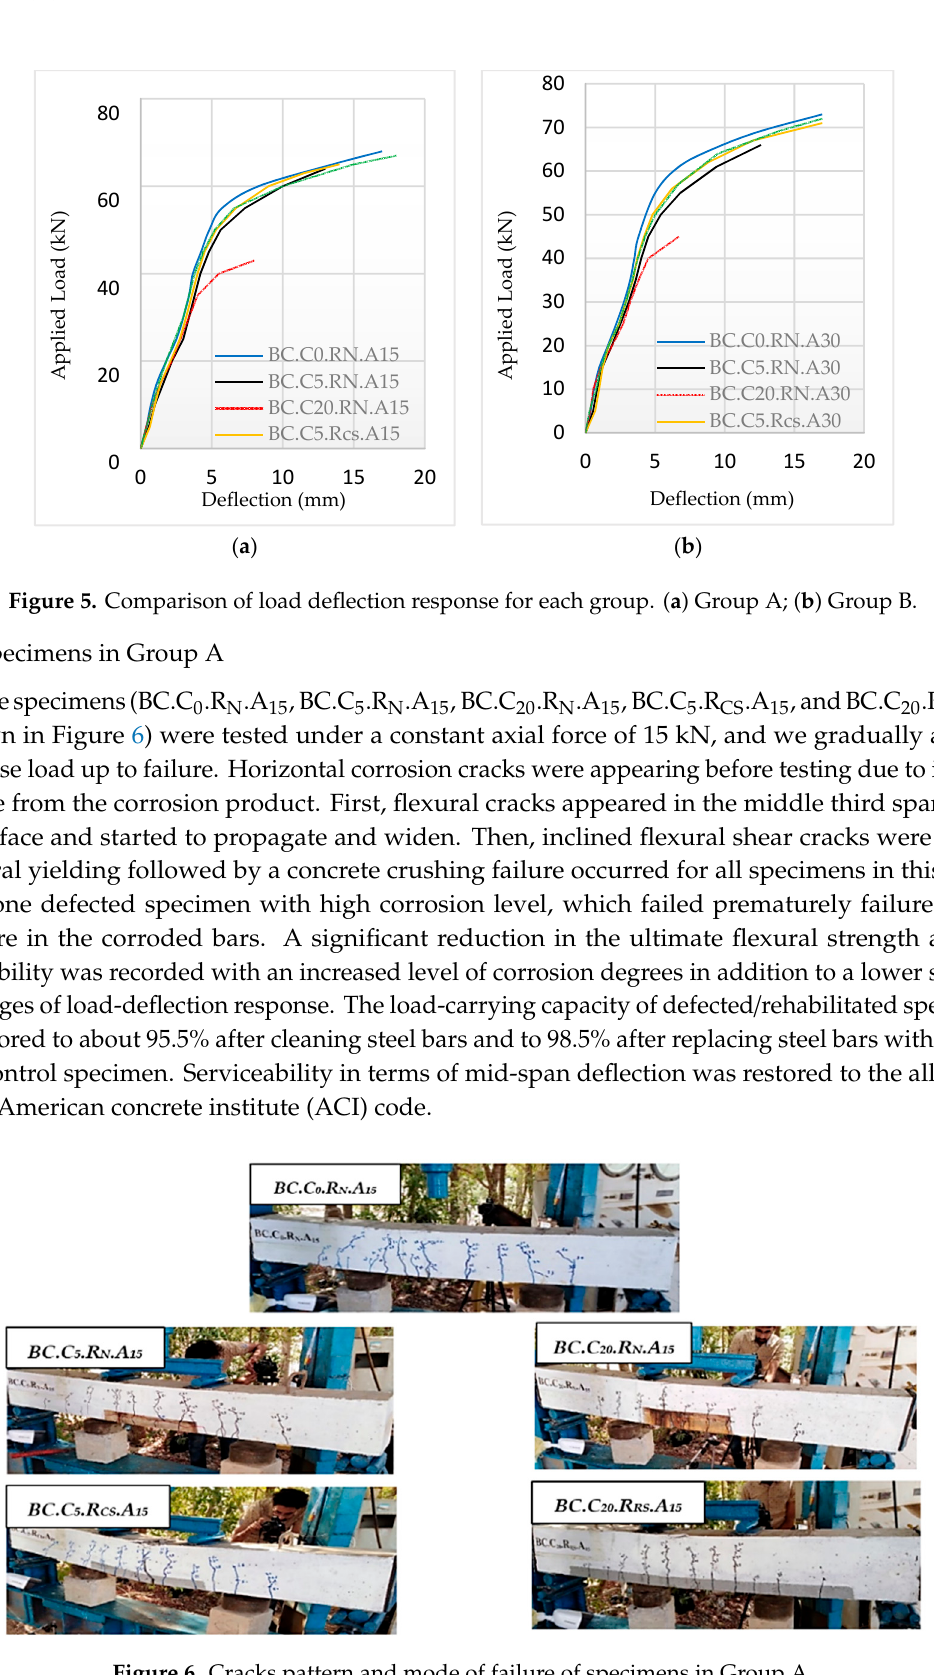
Figure 6. Cracks pattern and mode of failure of specimens in Group A.